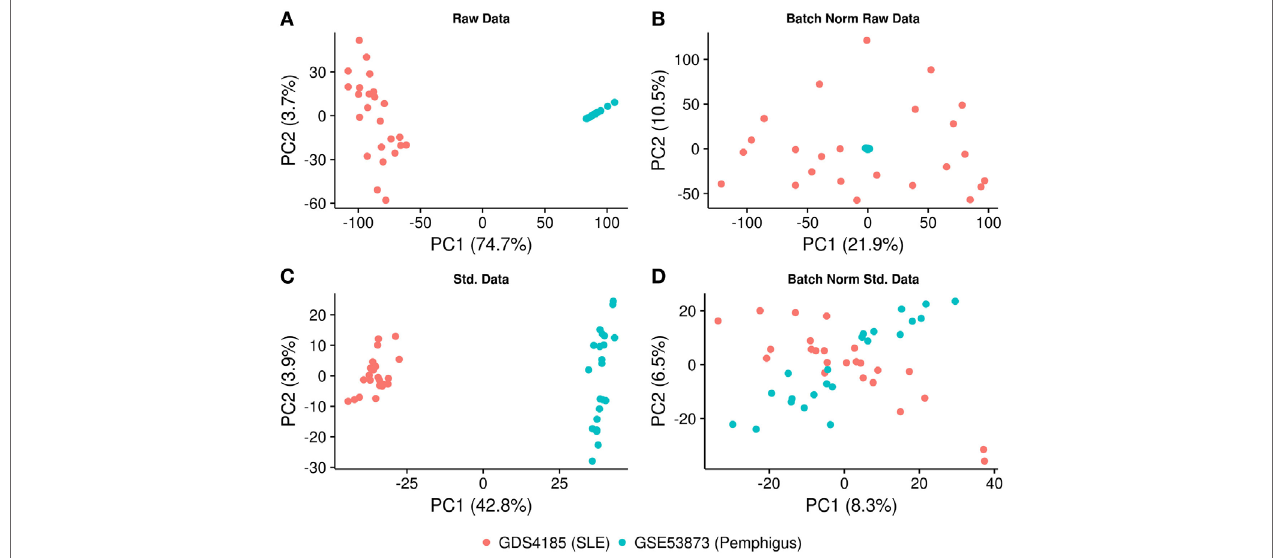
FigUre 1 | PCA plot illustrating the normalization procedure. (a) PCA plot showing clustering of the samples based on the gene expression profiling, before and (B) after batch correction on raw data. (c) PCA plot showing clustering of the samples after using identical background correction and normalization methods, before and (D) after batch correction. The X - and Y -axes represent the first and the second principal components and the associated percentage of variation.